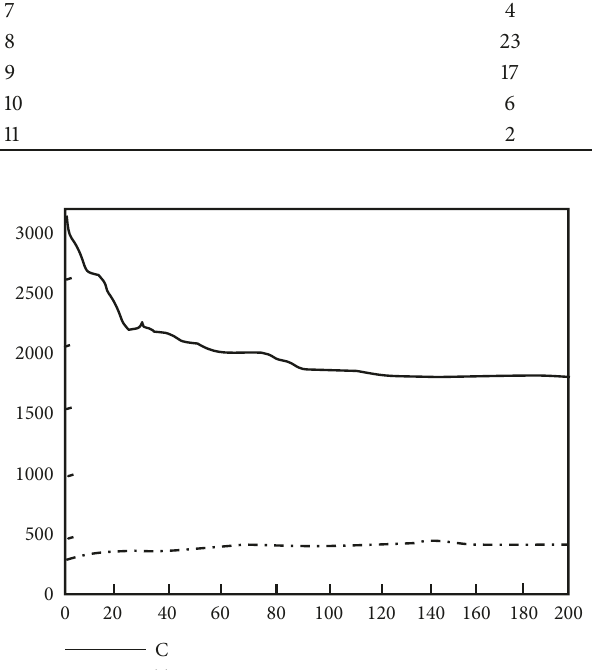
Figure 6: Therelationship between the numberof iterationsand the value of the objective